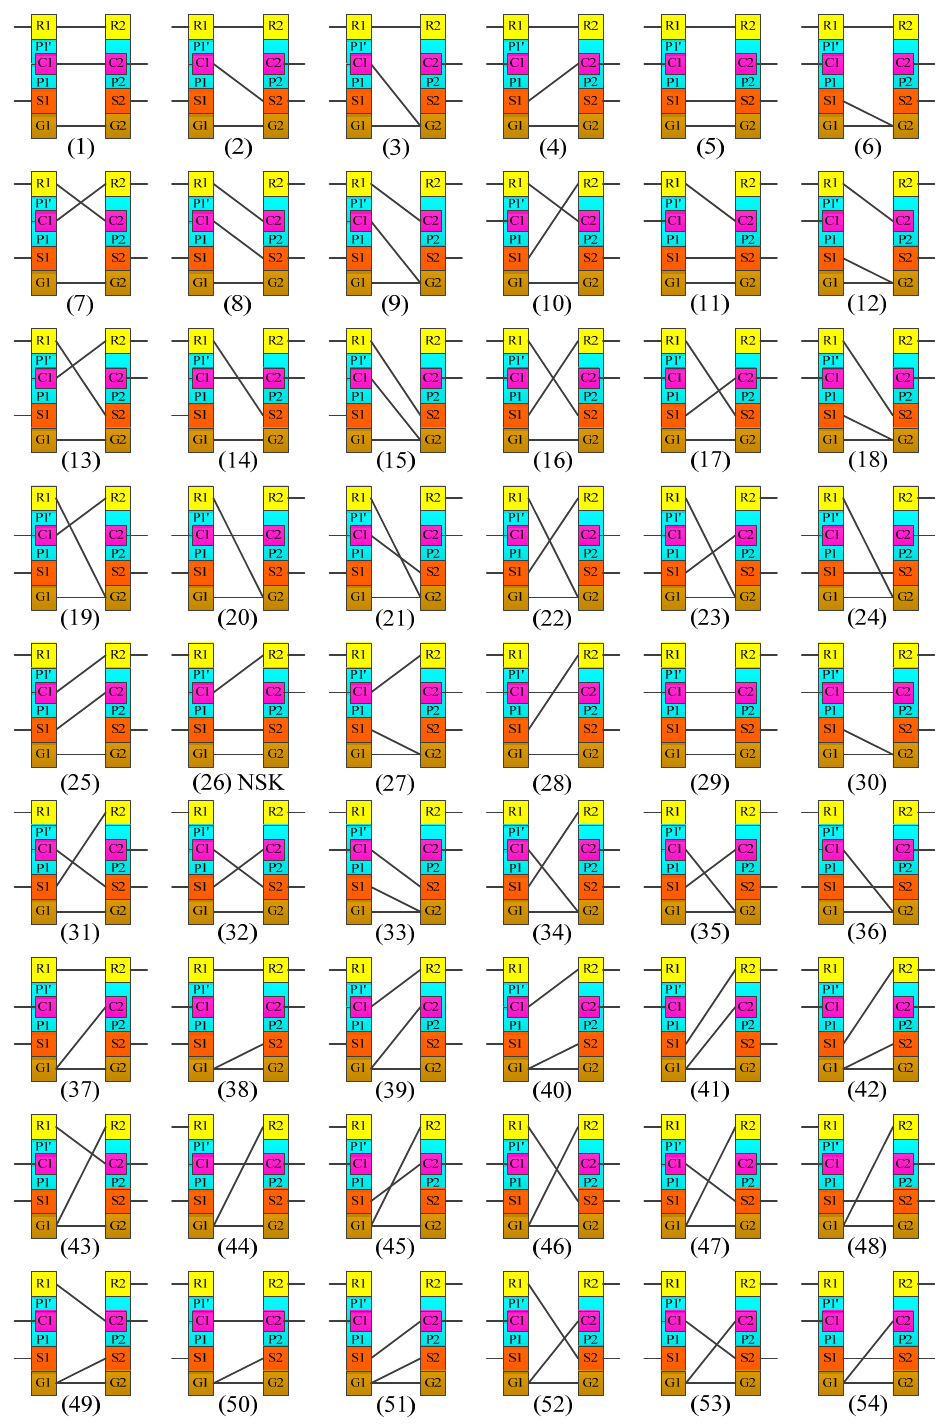
Figure 5. Atlas of eight-bar PGTs for hybrid transmission mechanism.